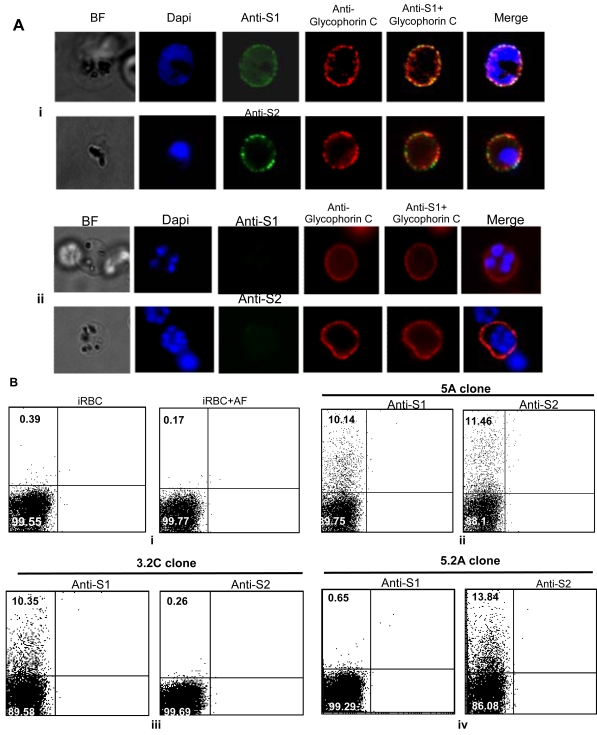
Visualization of STEVOR surface antigens.(A) Double staining of live 5A-iRBCs with either anti-S1 (or anti-S2) (panel i) with anti-Glycophorin C antibodies. Panel (ii) illustrates lack of surface STEVOR staining of 5B-iRBCs with both anti-S1 (upper row) and –S2 (lower row). The specific antibodies that reacted with the iRBC surface were detected with Alexa Fluor–labeled goat anti-rabbit (or anti-mouse) IgG. The fluorescent images (individual stains and merged) and the bright-field are shown. (B) Flow cytometry assay to measure STEVOR antigens at the iRBC surface. IRBCs alone or incubated with Alexa Fluor (AF) secondary antibody were used for controls (panel i). Live parasites of clones 5A (panel ii), 3.2C (panel iii), and 5.2A (panel iv) were incubated with anti-S1 and anti-S2 antibodies followed by the Alexa Fluor secondary antibody. Percentage of STEVOR-expressed iRBCs is shown as mean fluorescence in the upper left quadrant of each scatter plot, and Ethidium bromide–stained iRBCs appear in the lower left quadrant.